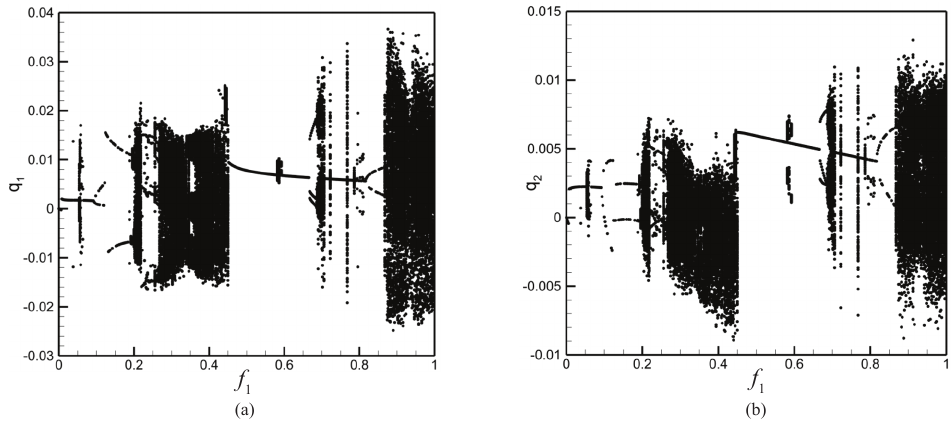
Fig. 9. Bifurcation diagrams of Poincaré points for increasing forcing amplitude on the system with c = 1 ,α = 1 . 5 and β = 0 . 3 .